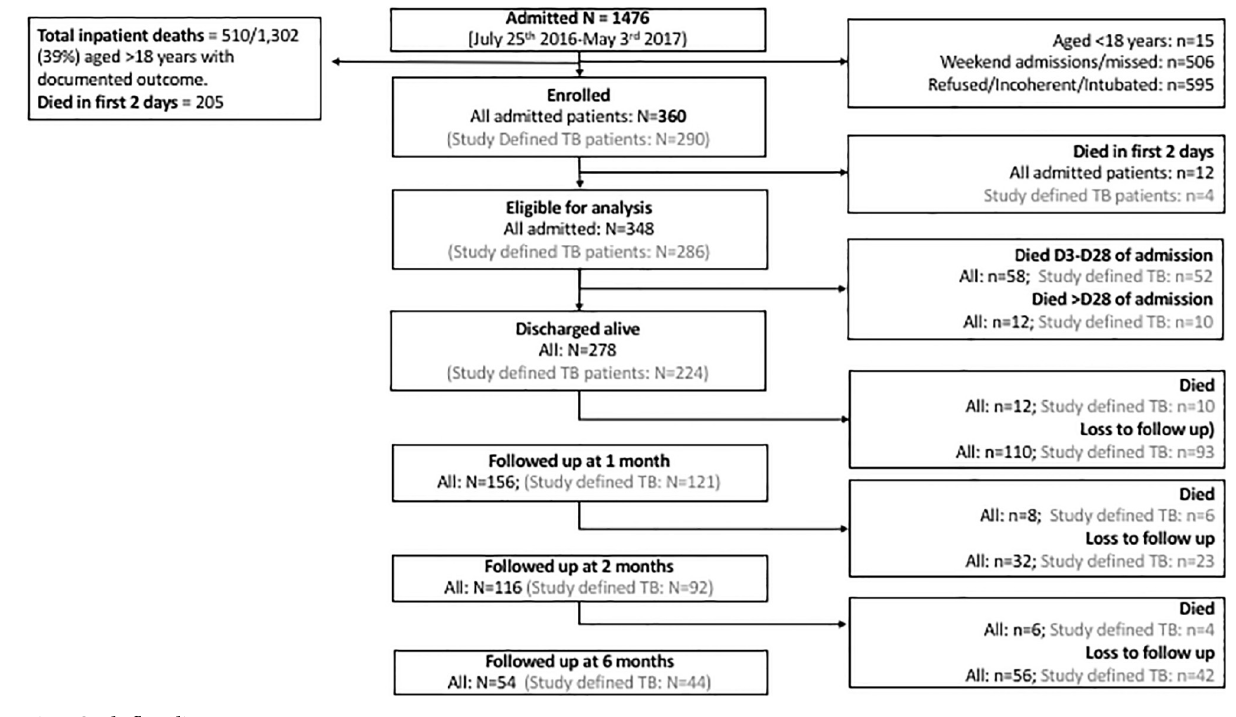
Fig 1. Study flow diagram.